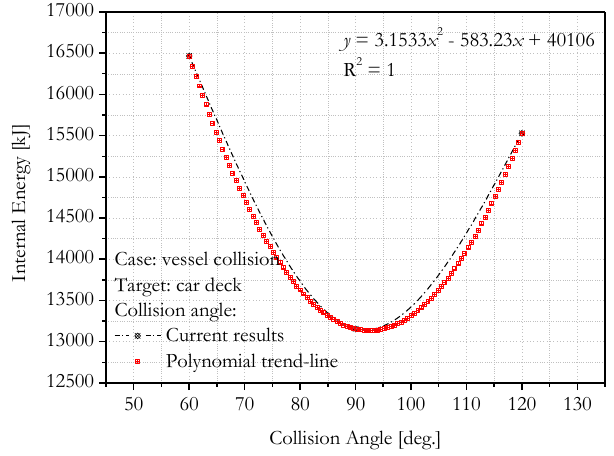
Figure 5. Pattern of the internal energy on a variety of collision angle.